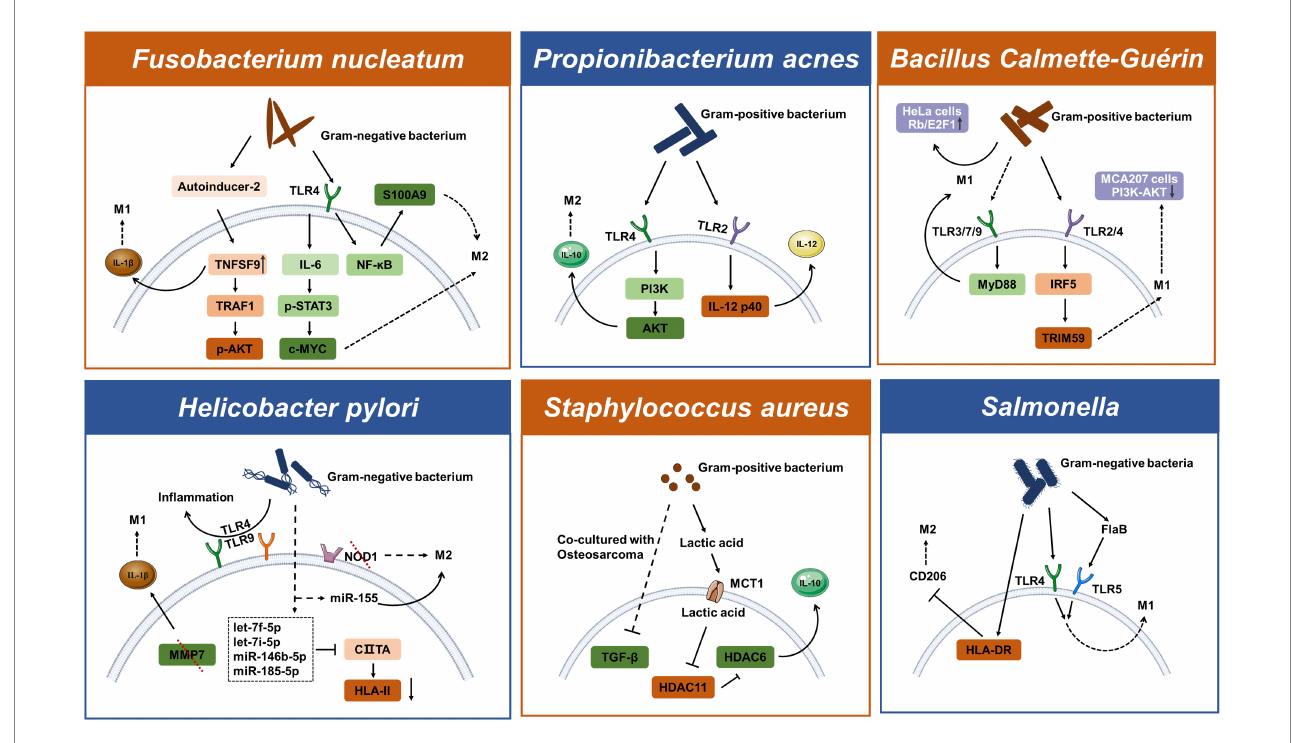
FIGURE 2 Schematic representation of mechanisms of bacteria-induced macrophage